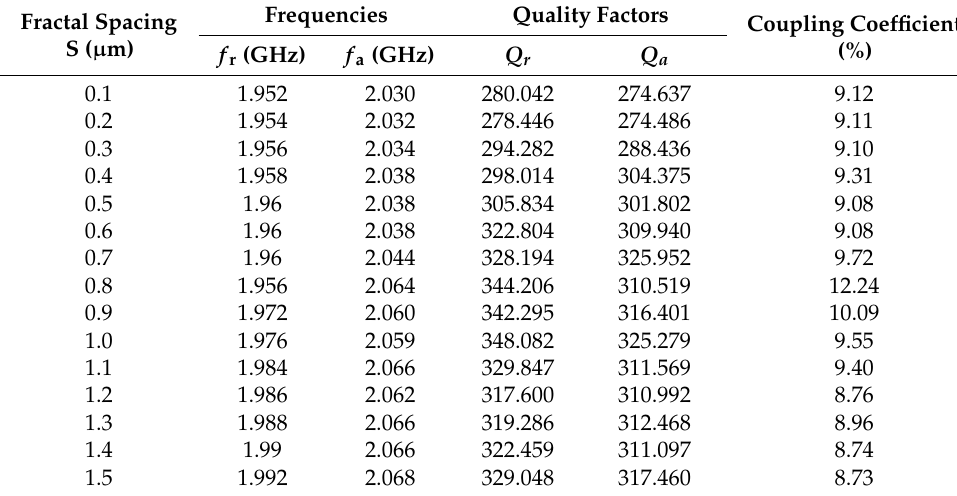
Figure 4. The eigen − mode of FBAR at resonance with ( a ) planar electrode and ( b ) fractal electrode. (The unit of displacement in the legend is µm)